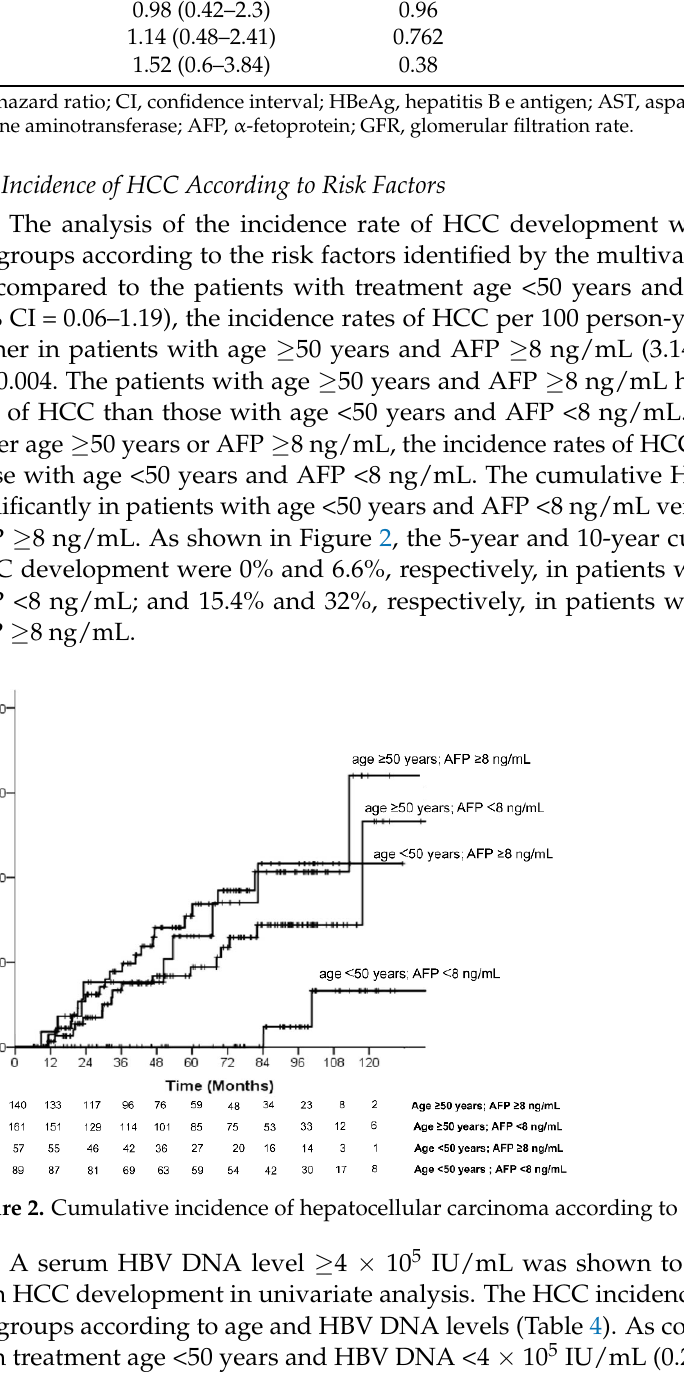
Table 3. Incidence rates of hepatocellular carcinoma stratified according to risk factors.